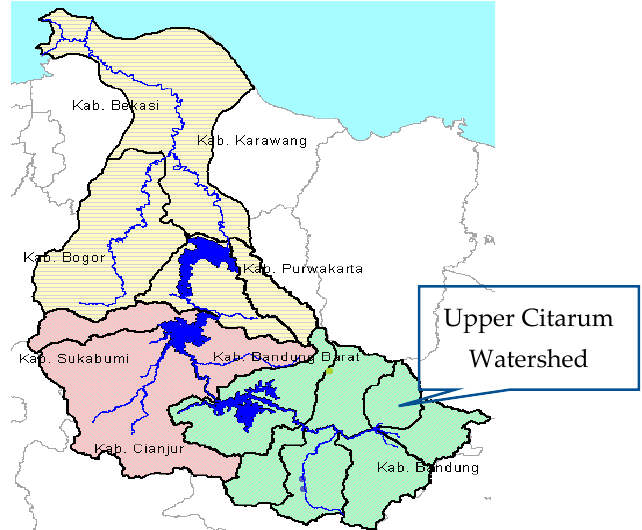
Figure 1. Map of Citarum